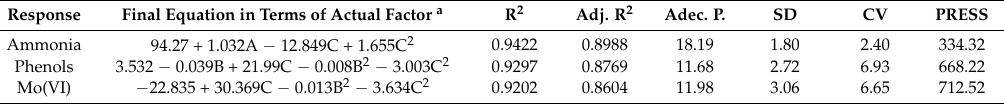
Table 4. Results of the analysis of variance of the response